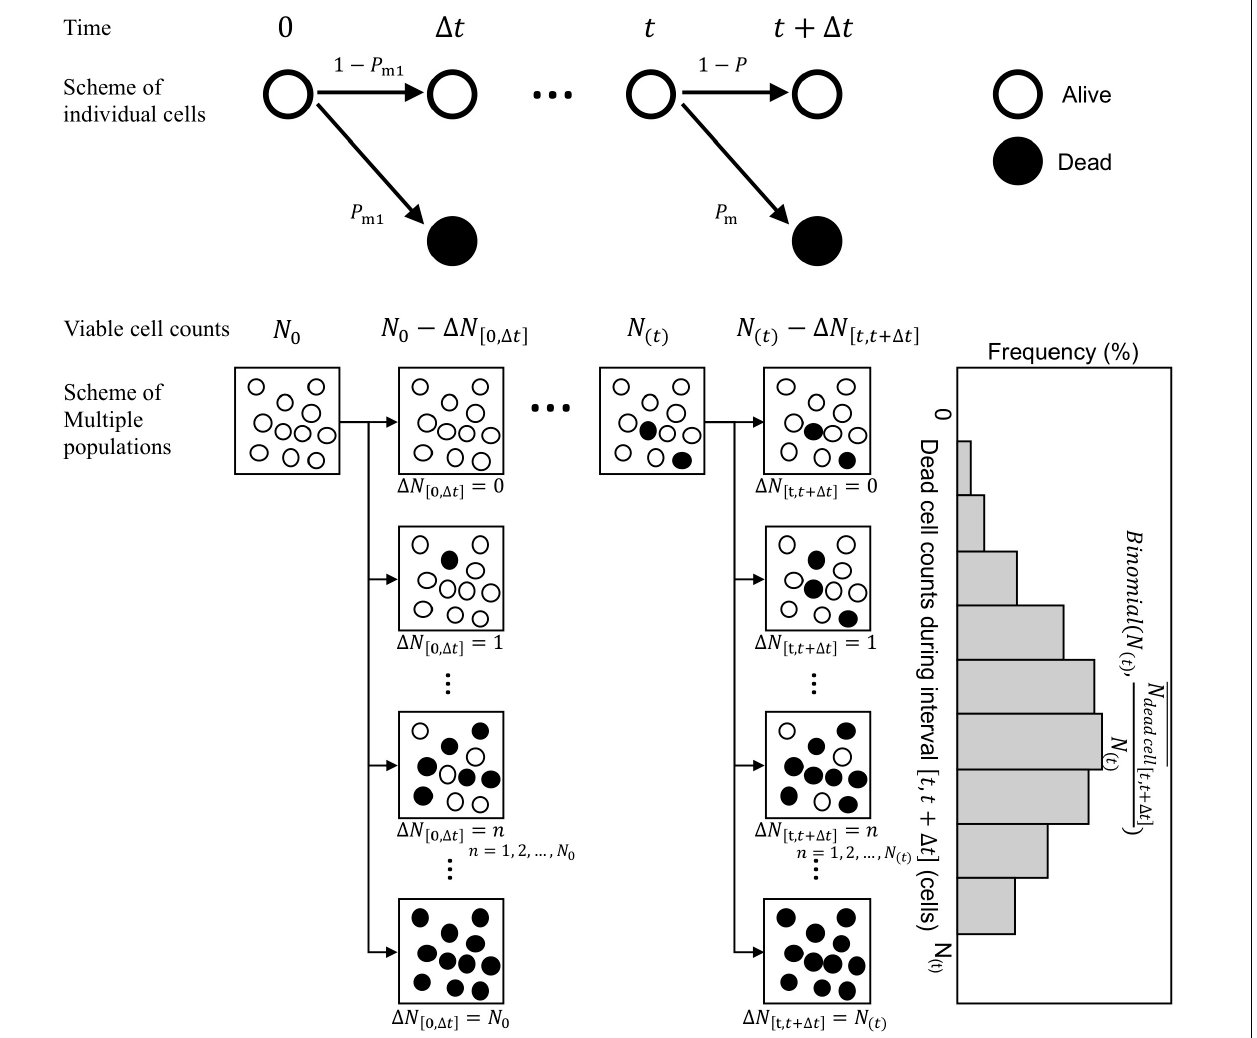
FIGURE 3 | Schematic of the Markov Chain Monte Carlo (MCMC) procedure. The proposed stochastic explanation describes bacteria death or continued survival based on the pure death process in the branch of modeling biological